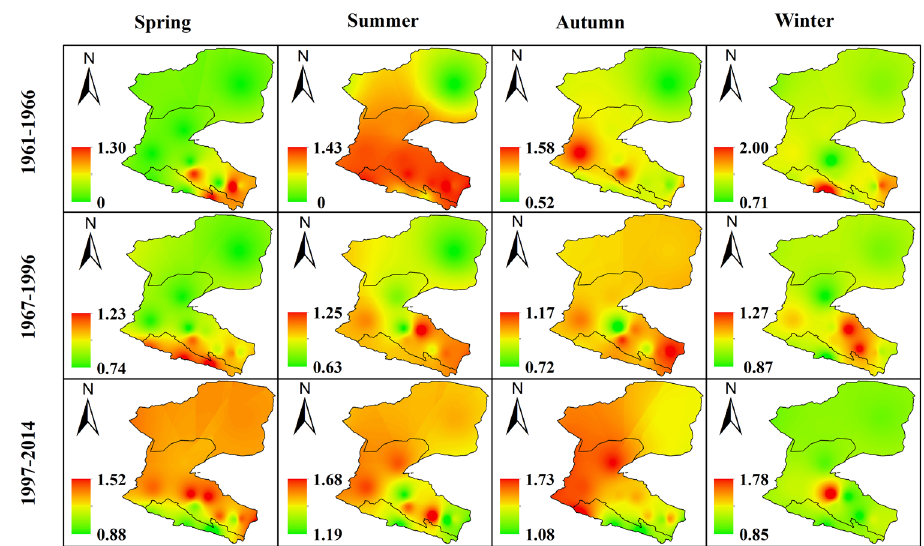
Fig. 9 Spatial distribution characteristics of seasonal drought intensity in the